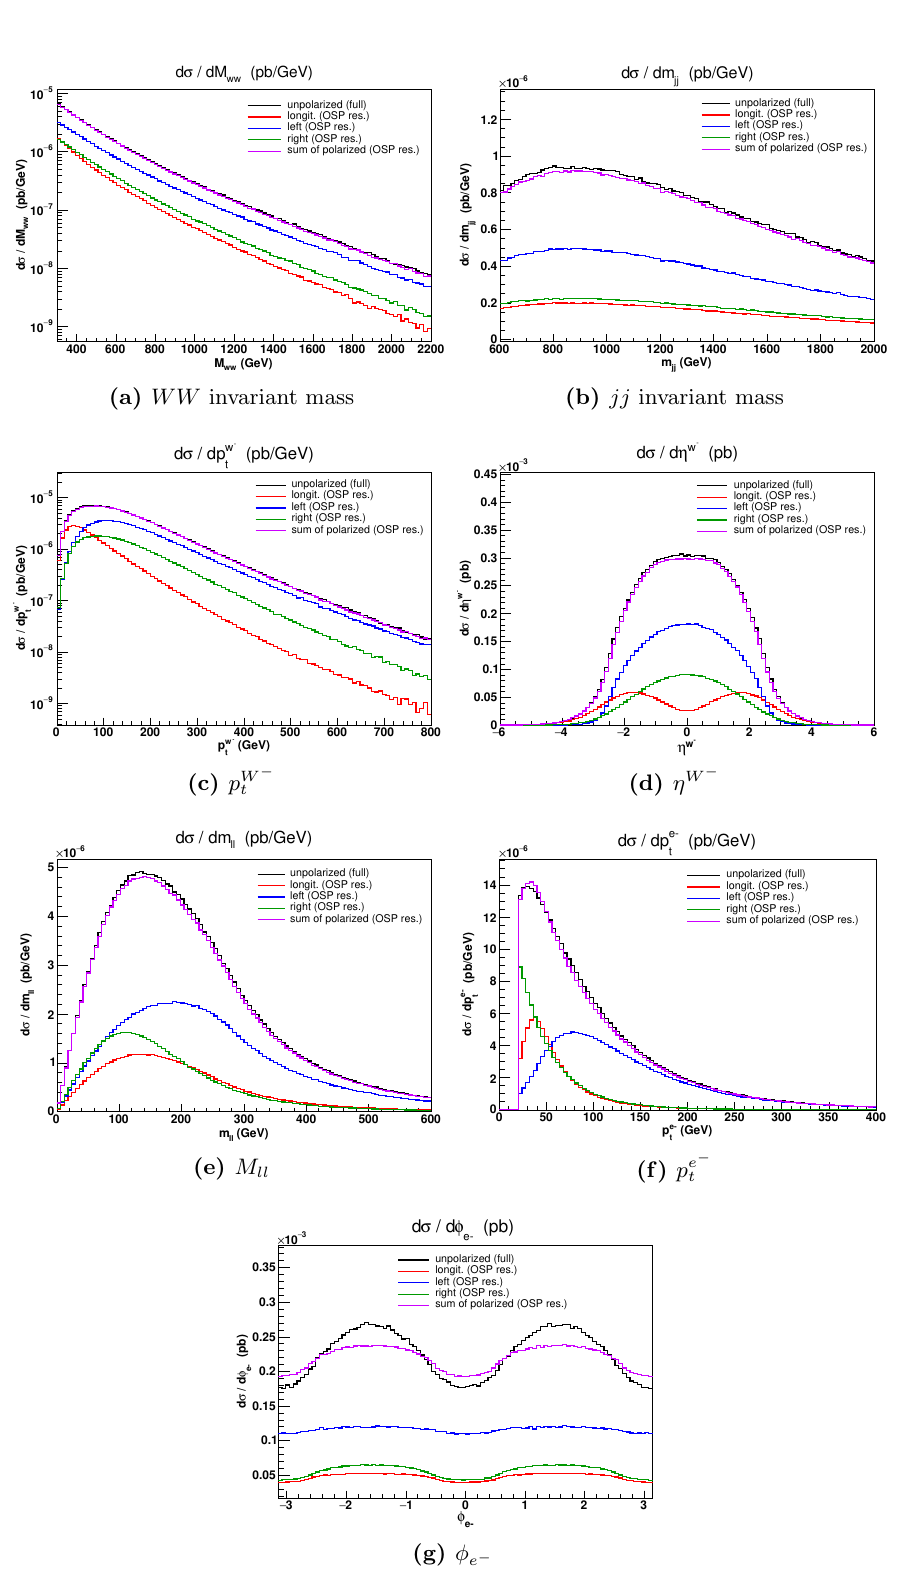
Figure 6. Di(cid:11)erential cross sections: comparison between unpolarized and sum of the polarized distributions. p e > 20 GeV, j (cid:17) e j < 2 : t